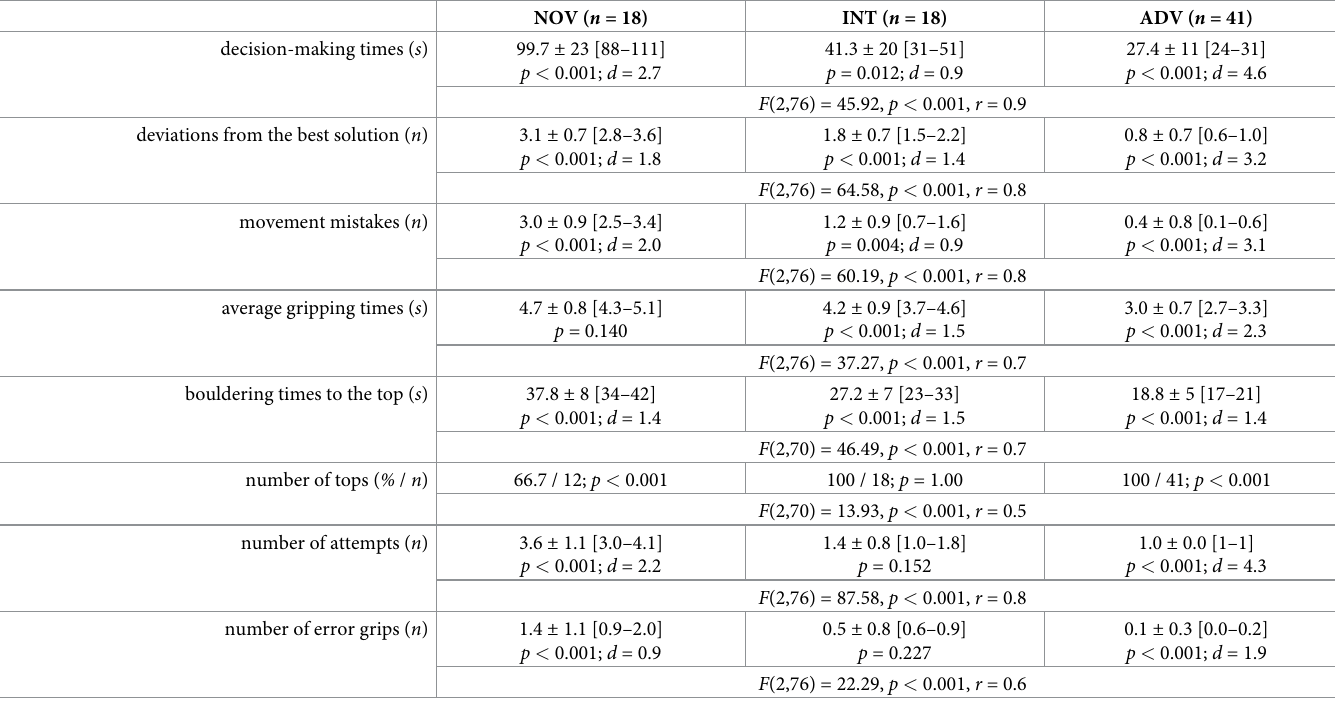
Table 3. Study results of the novice group (NOV), the intermediate group (INT), and the advanced group (ADV) in Experiment 2.